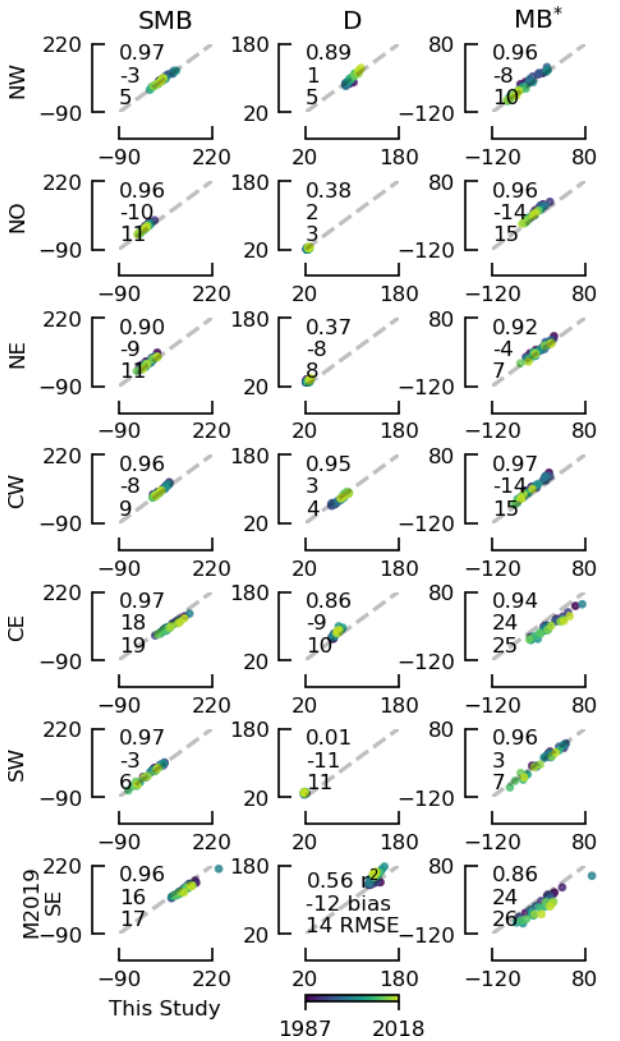
Figure B1. Comparison between This Study (excluding BMB) and Mouginot et al. (2019). Same data and display as Fig. 5 except here displayed by the Mouginot and Rignot (2019) region. Numbers in each graph show r 2 , bias, and RMSE from top to bottom, respec- tively. All axis units are Gtyr − 1 .